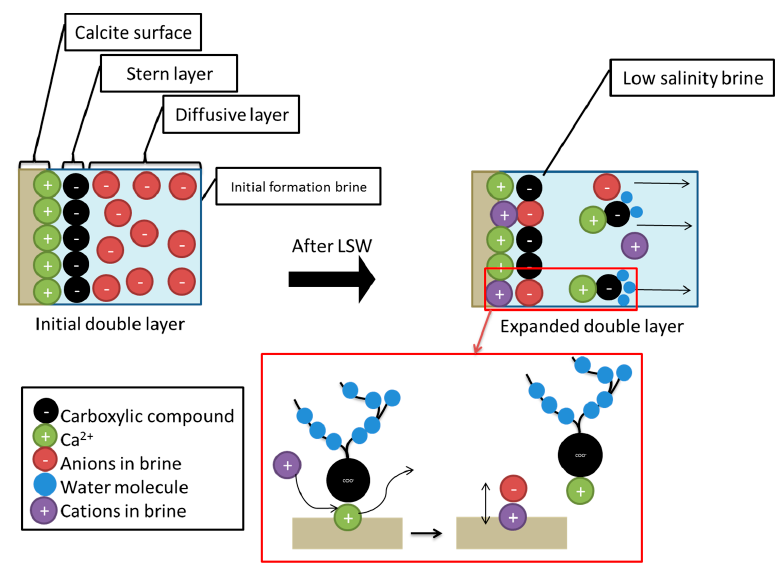
Figure 14. The mechanism of double layer expansion.